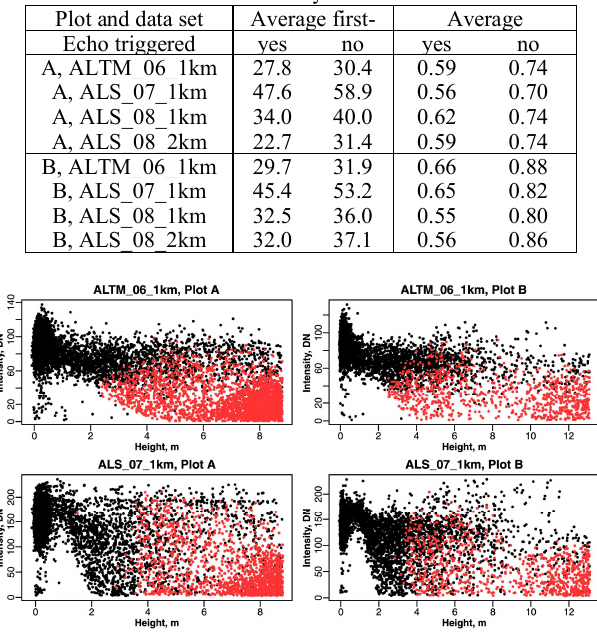
Table 5. Mean intensity in overstory echoes and average minimum stem - pulse distance (understory) for pulses that had intersected an understory tree.